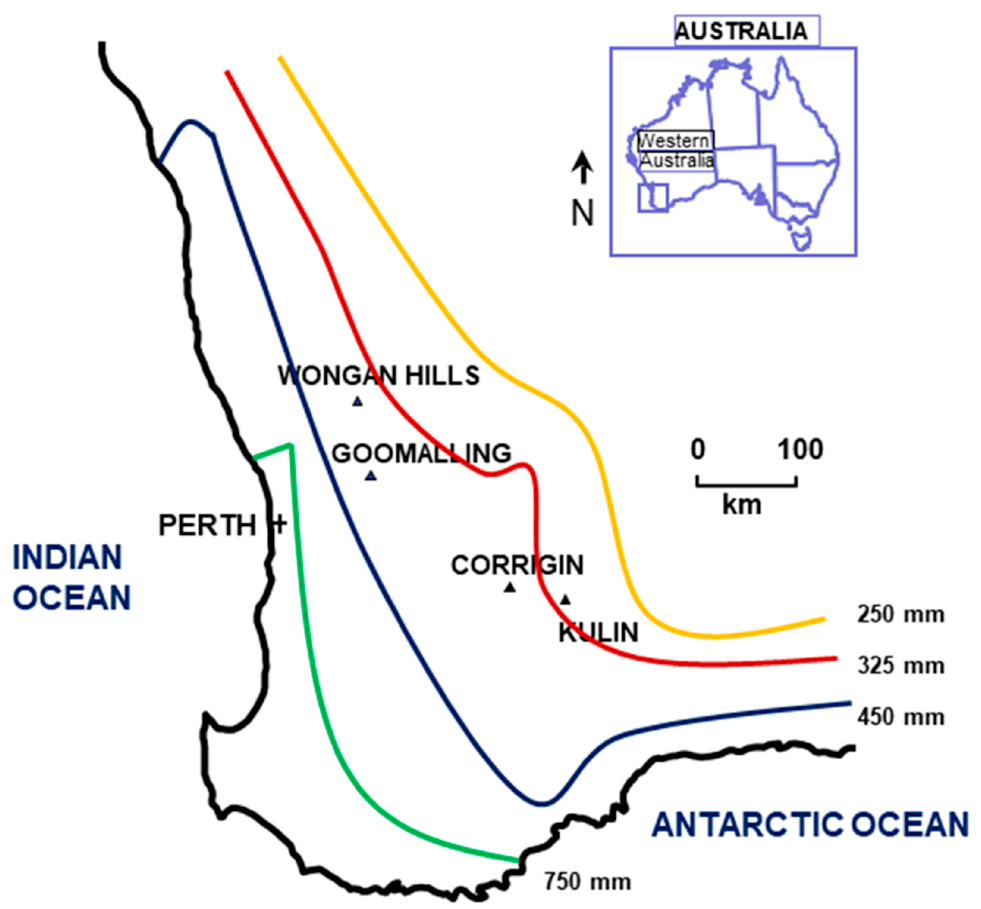
Figure 1. Collection sites in the south-west Australian grain belt where HPWMoV-infected wheat samples were obtained. The grain belt is subdivided into three zones with 250–325 (low), 325–450 (medium), and 450–750 (high) mm of rainfall per year.